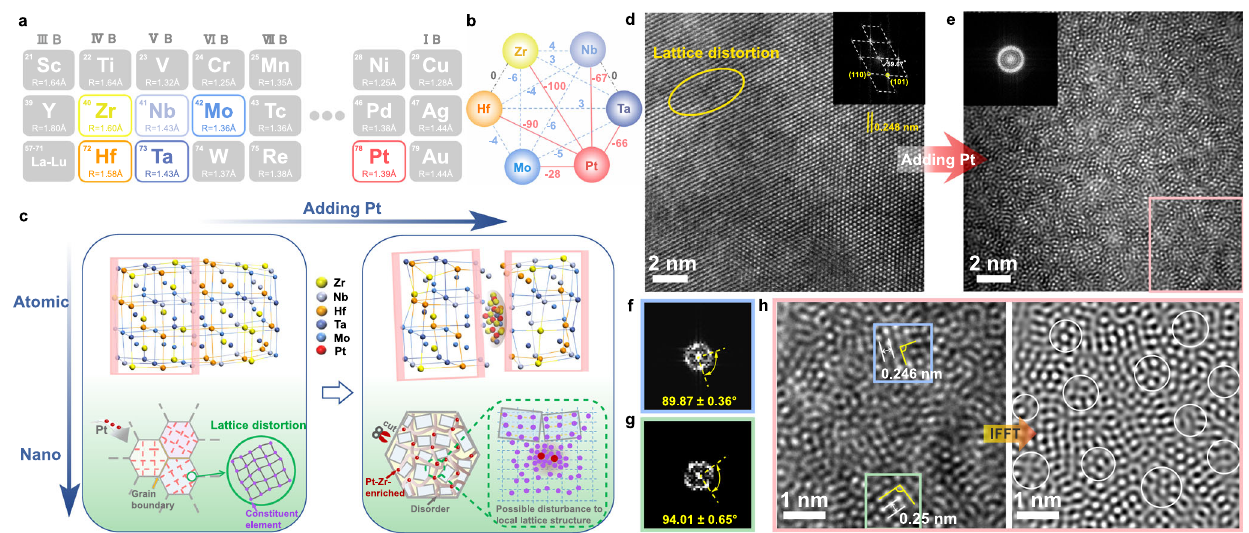
Fig.1|Illustrationofdesignstrategyandexperimentalcharacterizationofthe structural evolution from severe-distorted HEA to paracrystalline HEA. a , b Atomic size and mixing enthalpy of the selected elements for designing the desirable paracrystalline structure in HEA. The gray and blue dotted lines in ( b ) represent the zero and near-zero mixing enthalpy value between constituent ele- ments, respectively. The red lines in ( b ) represent the relatively much larger and more negative mixing enthalpy between Pt and other elements. c Schematic dia- gram of the “ atomic-level tailoring ” process that the induced disordered groups, drivenby foreign Pt atoms, separate the severe-distorted crystalline structureinto theparacrystallinestructuredominated bycrystallinemedium-rangeorder(MRO) (marked as pink boxes). Atomic bonding in disordered groups not shown in the